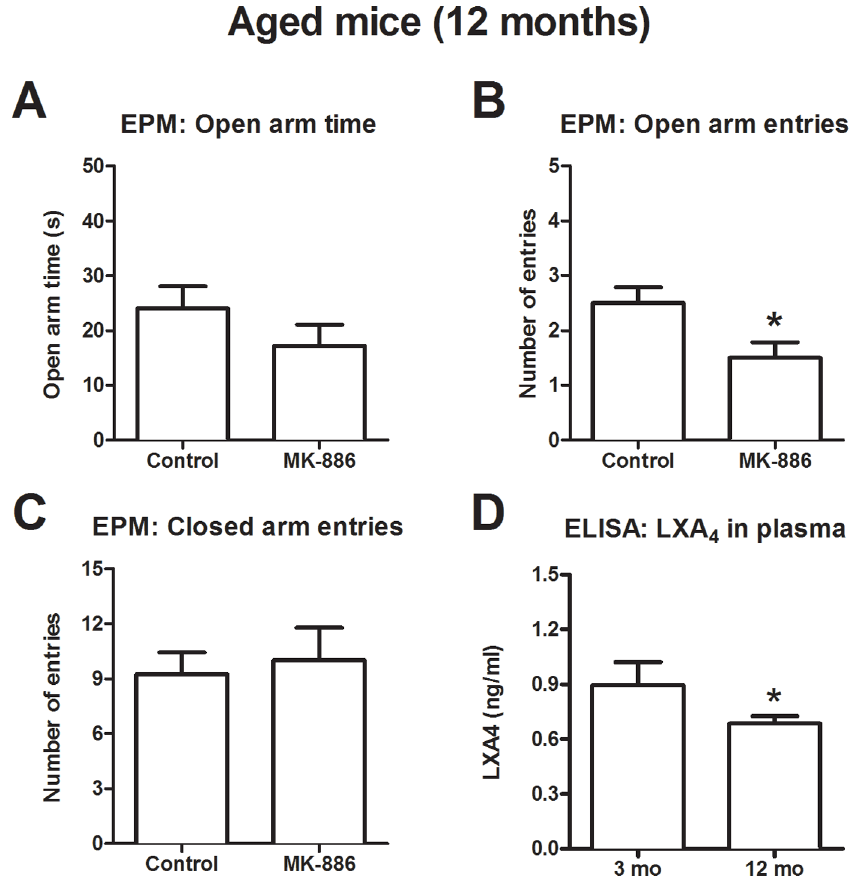
Figure 3. MK-886 induced anxiogenic-like behavior in 12-month-old Swiss mice in the EPM test. After treatment with MK-886 (10 mg/kg, i.p.) aged mice displayed a tendency toward reduced (A) open arm time and a significant decrease in the number of (B) entries in open arms, while no changes were observed in (C) entries in closed arms (n=4). (D) Twelve-month-old mice also show reduced lipoxin A 4 levels in plasma compared to 3-month-old mice (n=12 2 15). Data are presented as mean 6 SEM, statistical analysis was carried out by two-tailed Student’s t test. *p , 0.05 vs vehicle. mo: months.